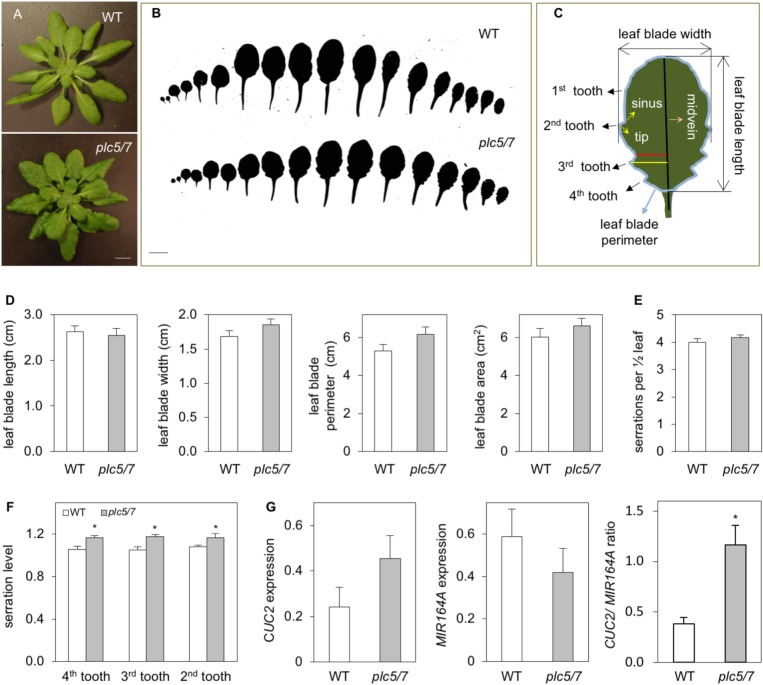
Leaves of plc5/7 plants display enhanced leaf serration. (A) Rosette of wild type and plc5/7 mutant. Plants were grown on soil for 4 weeks in short-day conditions, afterwhich rozettes were cut and photographed immediately. Bar = 1 cm. (B) Leaf series of 4-week old wild type and plc5/7 plant. (C) Cartoon demonstrating the leaf parameters measured of the 8th leaf. (D) Quantification of blade size including, length, width, perimeter and area. (E,F) Quantification of leaf serration number (E) and level (F) in wild type and plc5/7 mutant. (G) Expression of CUC2 and MIR164A and their ratio in WT and plc5/7 mutant, relative to the expression of reference gene, OTC. Data represents the means ± SD (n = 3) from a representative experiment that was repeated twice with similar results. Asterisk (∗) indicate significance at P < 0.05 compared to WT, based on Student’s t-test.